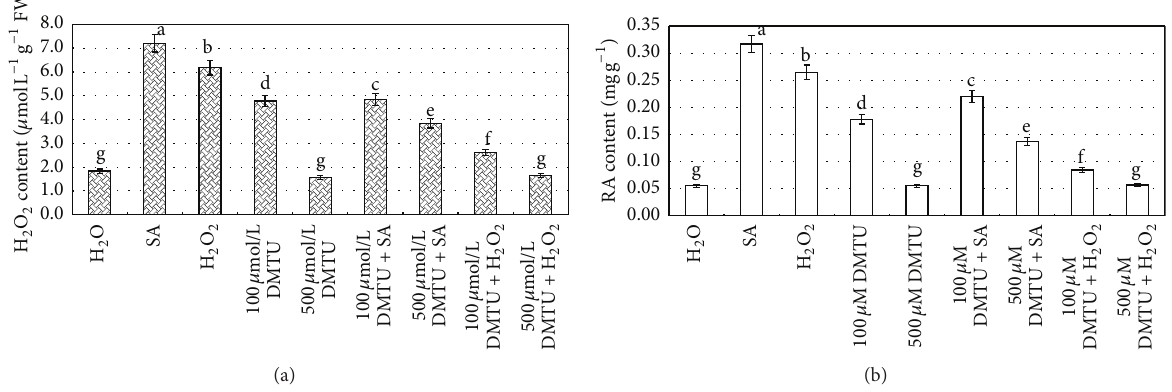
Figure 5: Inhibition of DMTU on exogenous SA in the generation of intracellular H 2 O 2 (a) and the biosynthesis of RA (b) in suspension cultured cells. 8-day-old suspension cultured cells treated with DMTU 30 min before exogenous H 2 O 2 and/or SA treatment as indicated were harvested at 8 h (for H 2 O 2 analysis) and 2 d (for RA analysis) later, and the H 2 O 2 and Sal B contents were then determined. The Salicylic acid concentration is 22.5 mg/L. The exogenous H 2 O 2 concentration is 10 mM. Values are means of three independent experiments. Bars represented standard errors. Different lowercase letters represent the significant differences between the contents of H 2 O 2 (a) and Sal B (b) after each treatment at the level of